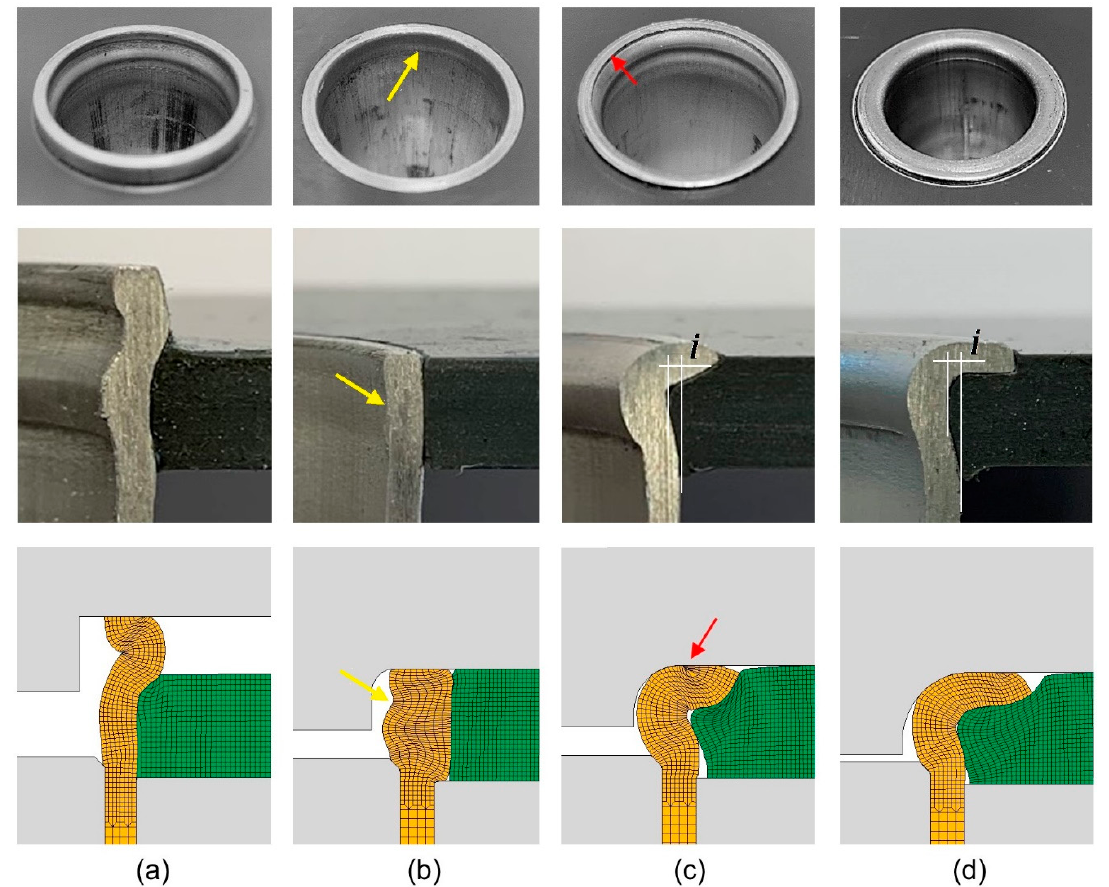
Figure 7. Experimental and finite element computed cross-sections of the typical modes of deformation that are observed in joining by tube flaring and sheet squeezing of Aluminum AA 6063-T6 tubes to PVC sheets: ( a ) Mode 0 ( r c = 0 mm, h = 6 mm); ( b ) Mode 0 ( r c = 1 mm, h = 4 mm); ( c ) Mode 1 ( r c = 2 mm, h = 4 mm); ( d ) Mode 2 ( r c = 3 mm, h = 4